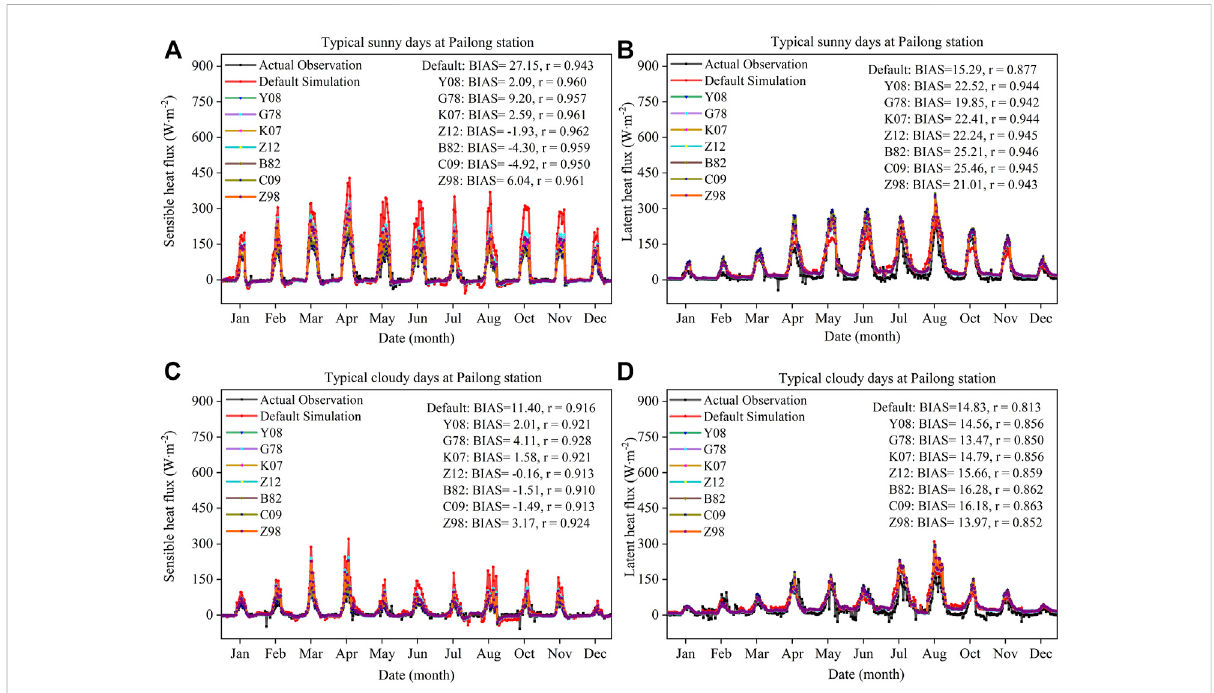
FIGURE 9 Comparisonofturbulent fl uxesbetweentheoriginalandrevisedversionswithseven Z 0h schemesagainstobservationsontypicalsunny/cloudy days at Pailong stations, where BIAS represents the simulation deviation and r is the correlation coef fi cient, (A and C) H, (B and D) LE, unit: (W · m − 2